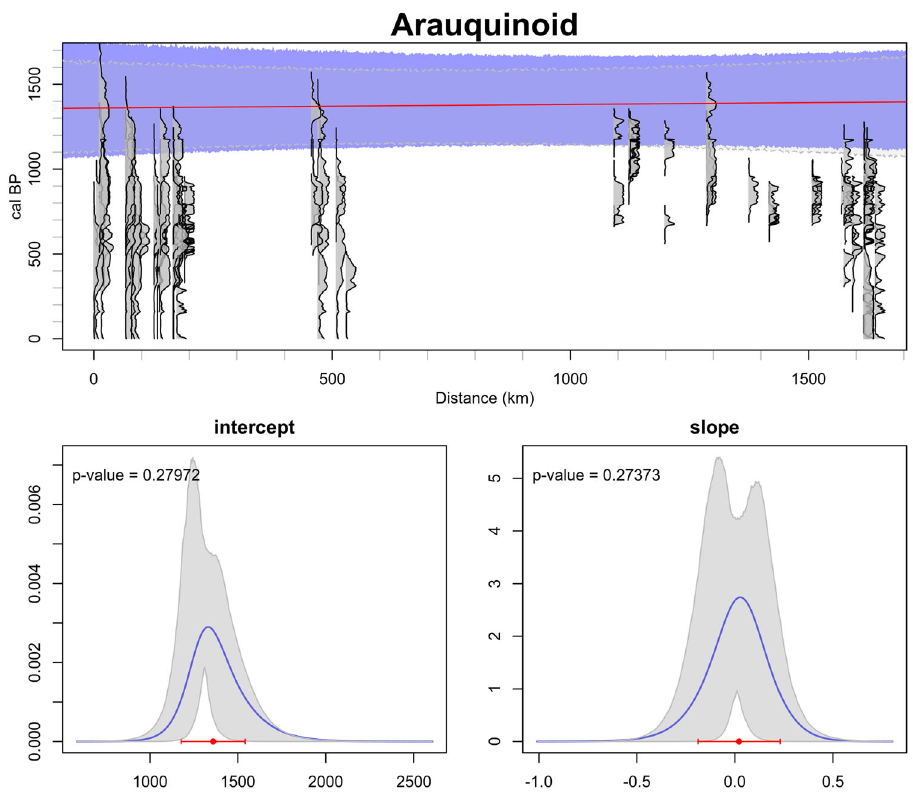
Fig. 3 Results of the radiometric regression analysis on the Arauquinoid dataset. Top: Bivariate plot of age versus distance from chosen origin, showing the calibrated radiometric densities (grey curves), the result of the quantile regression to 99th-percentile when using median dates (red line), the spread of regressed lines when taking the full radiometric uncertainty into account (blue-shaded region), and the con fi dence envelope of the null hypothesis of no- dispersal (grey-shaded region with dashed border). Bottom Left: Summed probability density of obtained y -intercept regression parameter for the empirical dataset (blue curve), con fi dence envelope of the null hypothesis of nodispersal (grey-shaded region), best estimate and corresponding 95% range when doing regression with median dates (red dot and bar). Bottom Right: Summed probability density of obtained slope regression parameter with the same key as the previous panel.